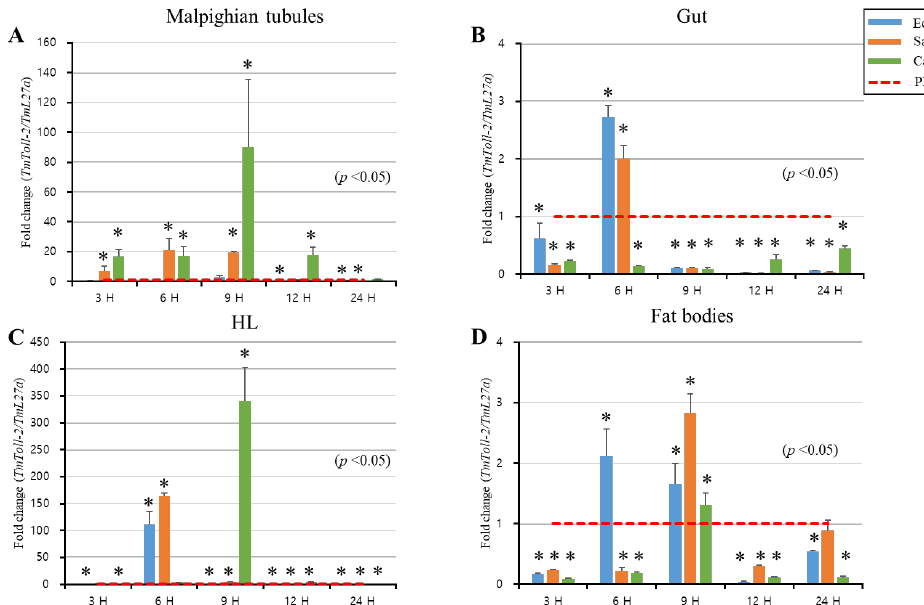
Figure 3. mRNA expression patterns of TmToll-2 in immune-challenged T. molitor larvae. mRNA levels of TmToll-2 in the Malpighian tubules ( A ), gut ( B ), hemocytes ( C ), and fat bodies ( D ) were examined by qRT-PCR 3, 6, 9, 12, and 24 h after infection with E. coli (10 6 cells/µL), S. aureus (10 6 cells/µL), and C. albicans (5 × 10 4 cells/µL). TmToll-2 mRNA expression was upregulated in response to all infectious sources and varied in tissue- and time-dependent manners. The upregulation of TmToll-2 gene expression was the highest in the hemolymph and MTs against C. albicans . PBS was used as an injection control, and T. molitor 60S ribosomal protein 27a ( TmL27a ) primers were used as internal control (n = 3). Asterisks indicate significant differences between infected and PBS-injected larval groups by Student’s t -test ( p < 0.05). Vertical bars indicate means ± SD (n =